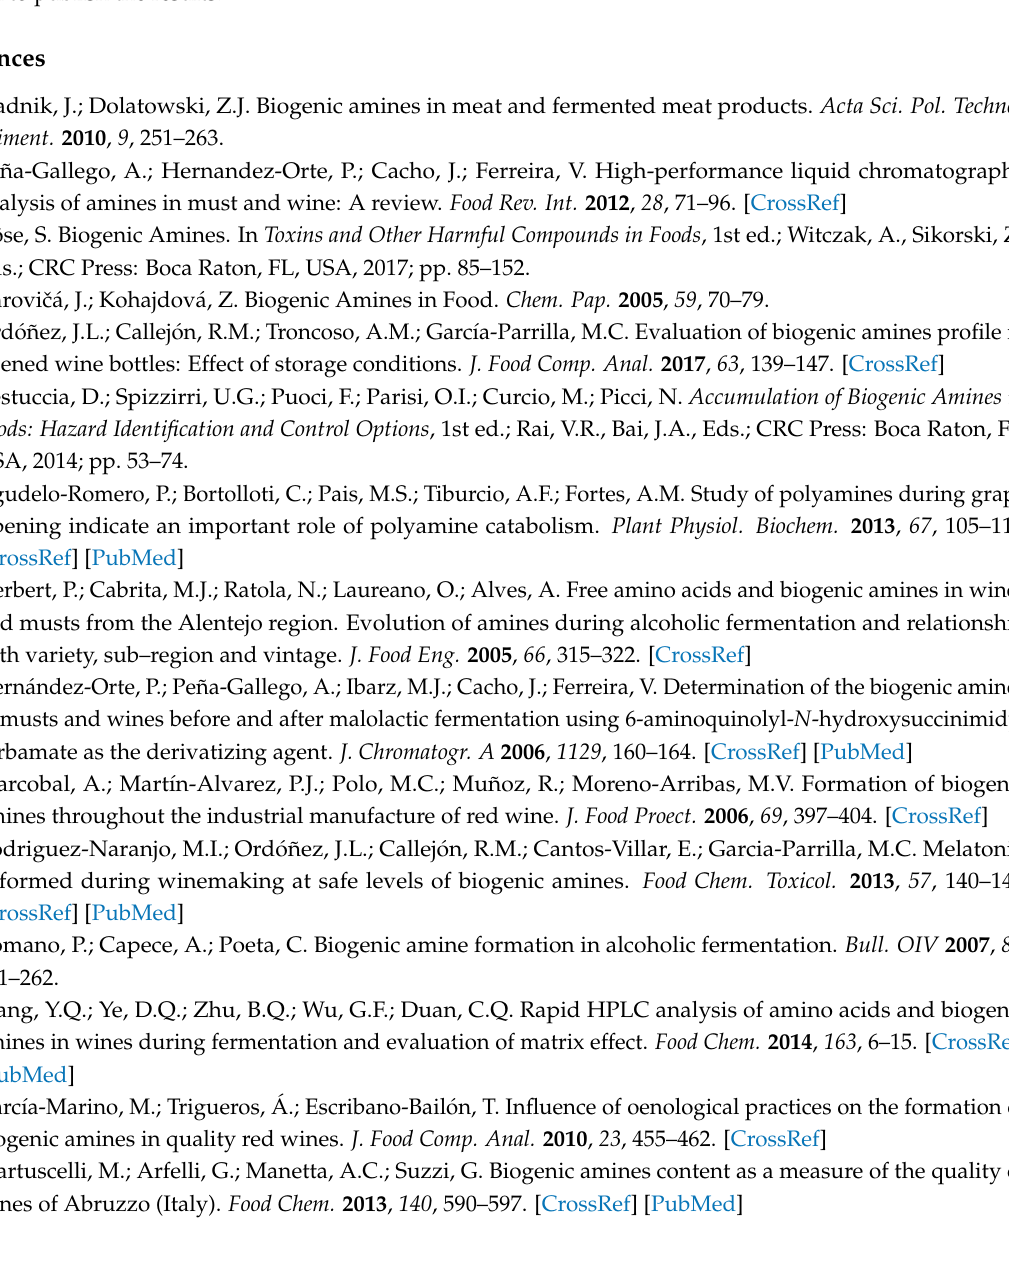
Supplementary Materials: The following are available online, Figure S1: Variable clustering for Wine B, Figure S2: Variable clustering for Wine C, Figure S3: Variable clustering for Wine D, Figure S4: Variable clustering for Wine E, Figure S5: Variable clustering for Wine F, Figure S6: Hierarchical dendrogram for wine samples (Wine B), Figure S7: Hierarchical dendrogram for wine samples (Wine C), Figure S8: Hierarchical dendrogram for wine samples (Wine D), Figure S9: Hierarchical dendrogram for wine samples (Wine E), Figure S10: Hierarchical dendrogram for wine samples (Wine